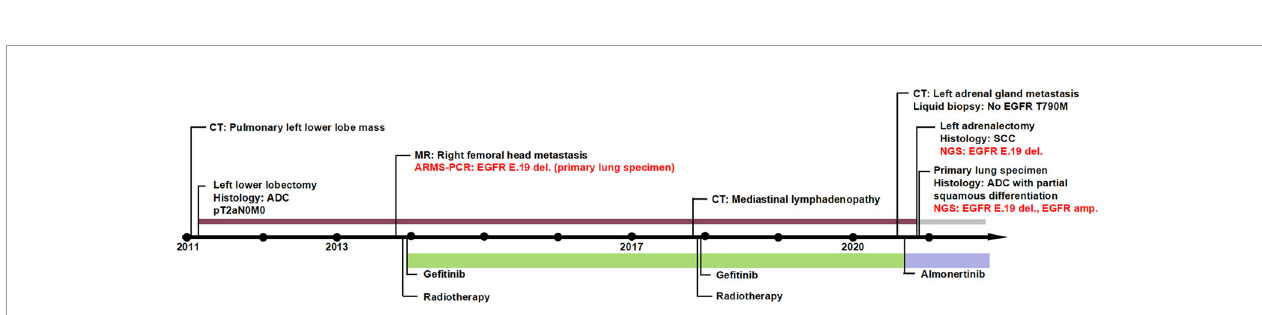
FIGURE 3 | Timeline of the clinical